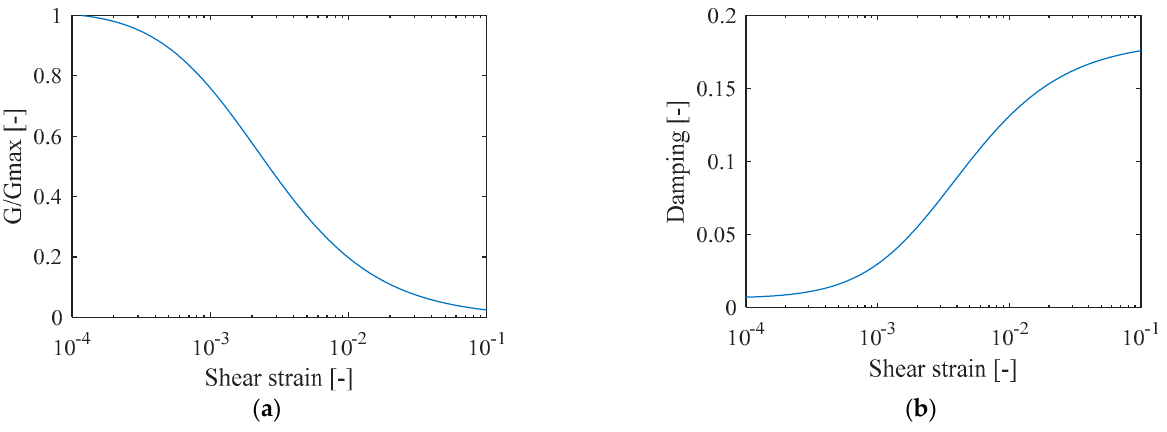
Figure 7. Evolution of the dynamic properties of a plastic soil (PI = 50) with shear strain: ( a ) stiffness degradation; ( b ) damping increase [31].